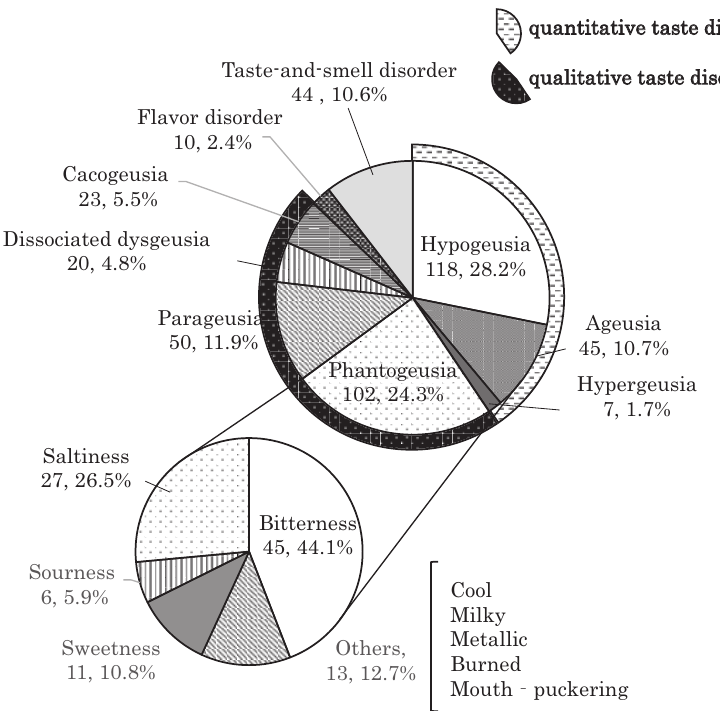
Figure 3. Distribution of the types of taste disorders. The most frequent type of quantitative taste disorder was hypogeusia (118, 28.2%), followed by ageu- sia (45, 10.7%) and hypergeusia (7, 1.7%). The most frequent type of qualitative taste disorder was phantogeusia (102, 24.3%), followed by parageusia (50, 11.9%), cacogeusia (23, 5.5%) and dissociated dysgeusia (20, 4.8%). Taste–and–smell disorders and flavor disorders were diagnosed in 44 and 10 pa- tients (10.6% and 2.4%), respectively.